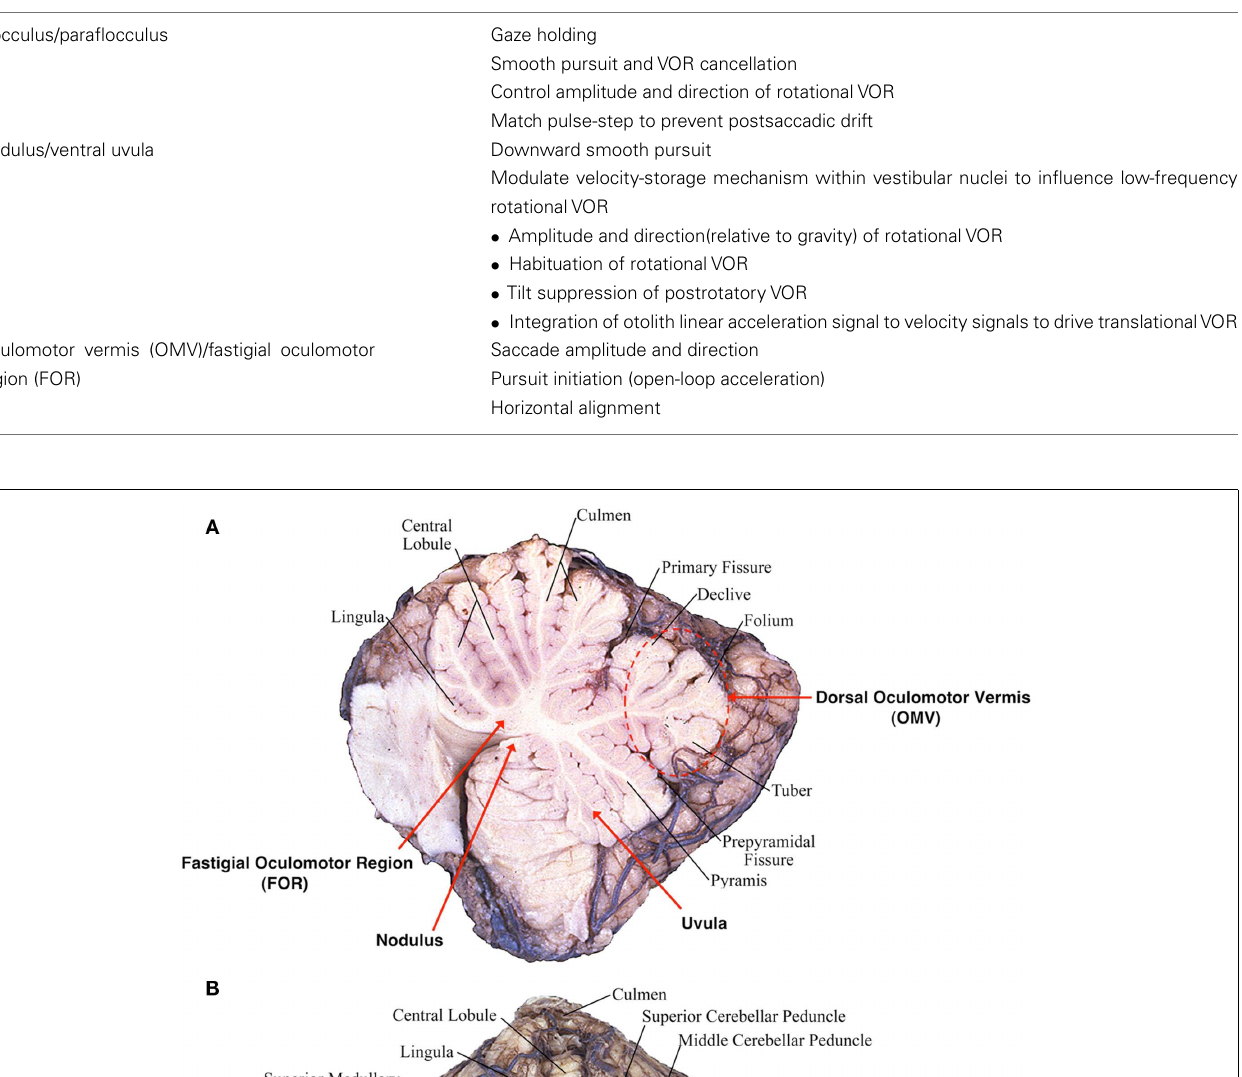
the eye during smooth pursuit, vergence, and vestibular responses to head motion (the vestibular–ocular reflex or VOR). Only sac- cades seem to be largely free of the influence of the flocculus